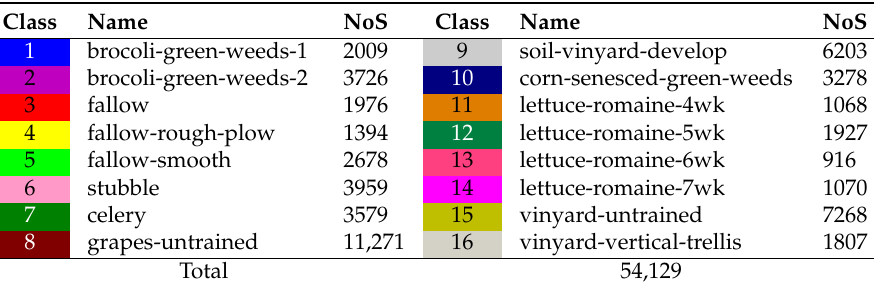
Figure 8. Salinas data. ( a ) Three-band false color composite and ( b ) ground truth data with 16 classes. Table 3. NoS used in the Salinas